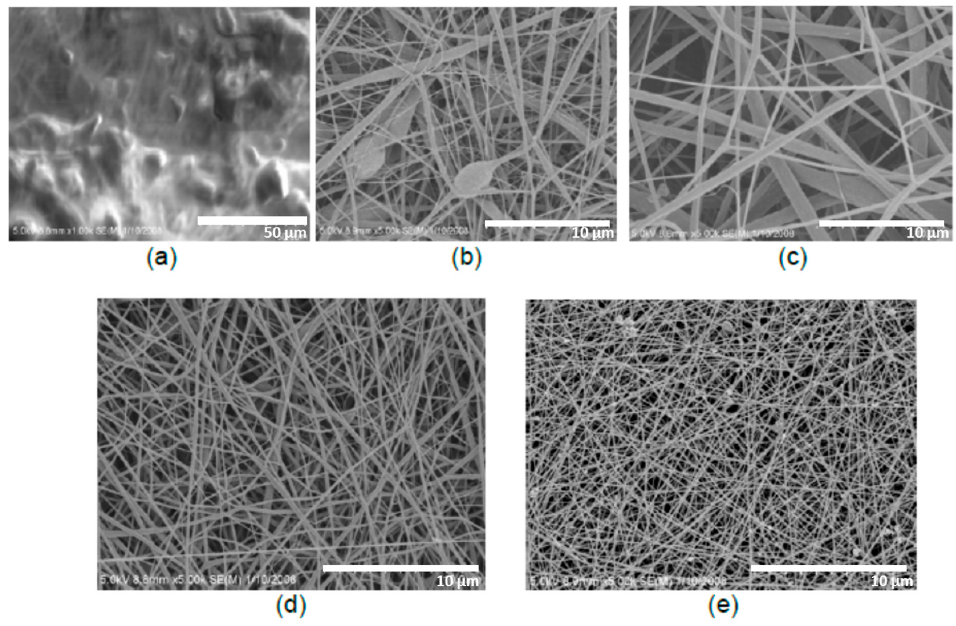
Figure 8. FE-SEM images of electrospun PVDF nanofibers prepared at ambient temperatures at ( a ) 5 °C, ( b ) 15 °C, ( c ) 25 °C, ( d ) 35 °C, ( e ) 45 °C. Reprinted with permission from [95].